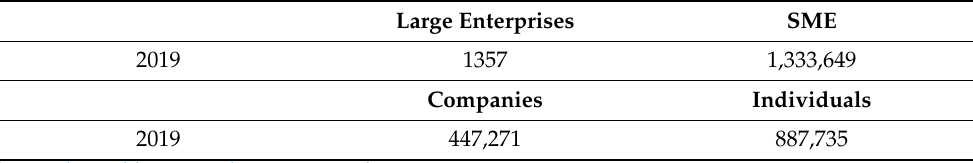
Table 1. Size of companies and weight of corporations and sole proprietorships in